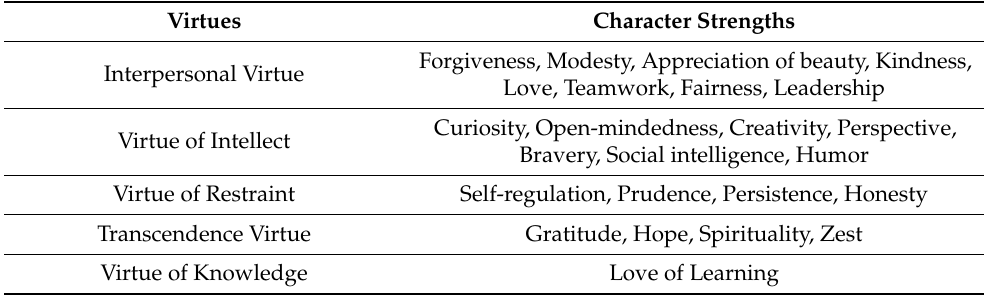
Table 1. The five virtues and their character strength constituents. Virtues Character